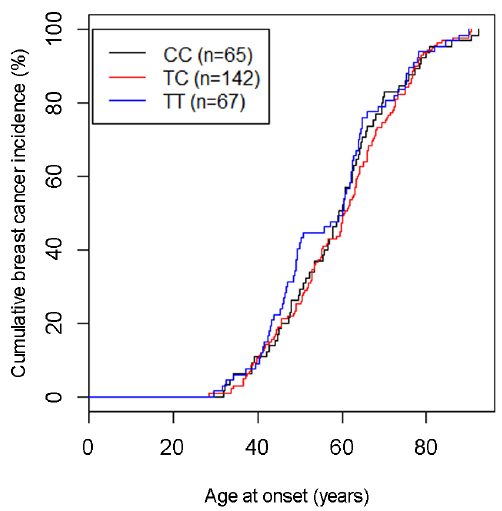
Figure 2. Curves of the cumulative breast cancer incidence at the indicated ages at onset of patients with genotypes CC, TC and